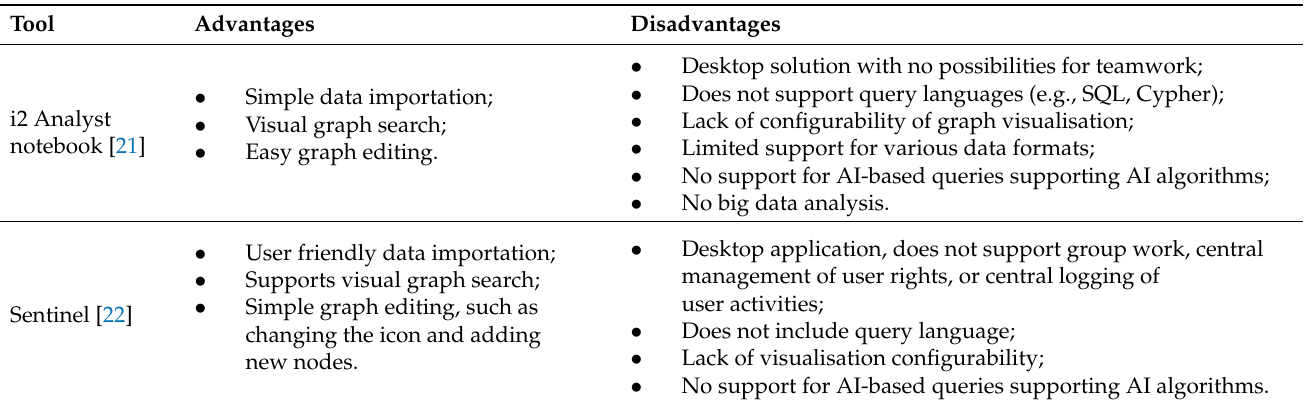
Table 1. Comparison of state-of-the-art investigation